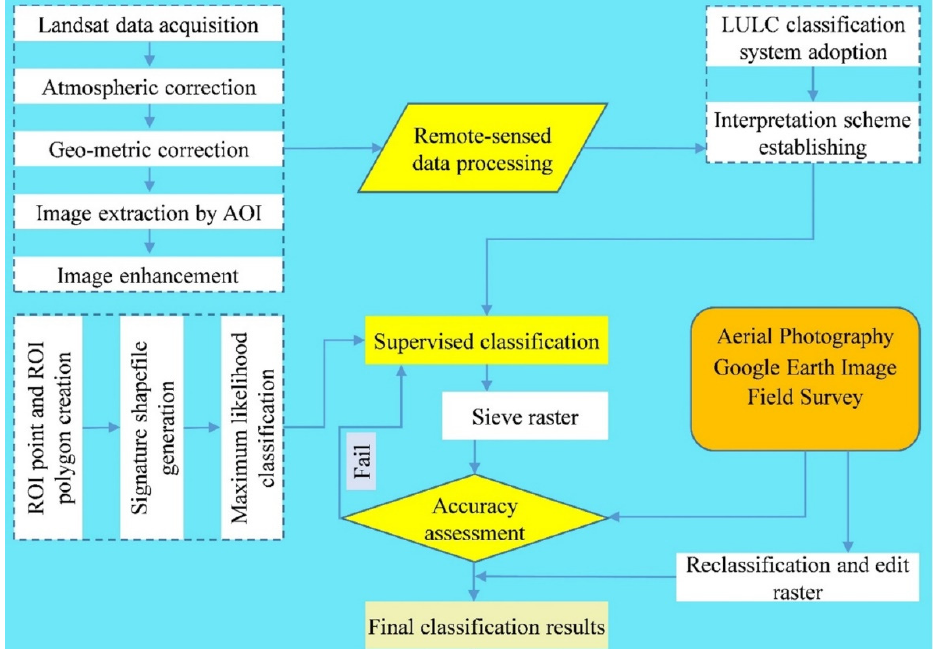
Figure 2. LULC classification framework.